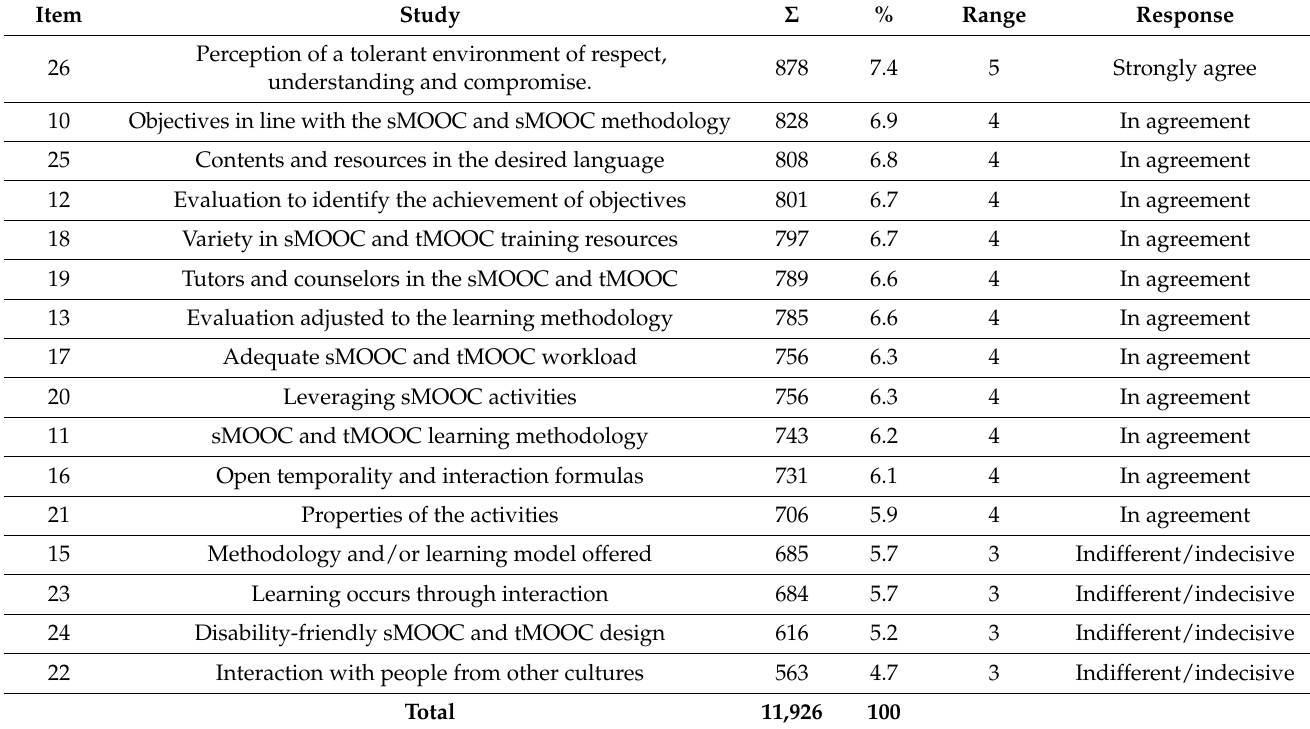
Table 3. Scale and percentage obtained per